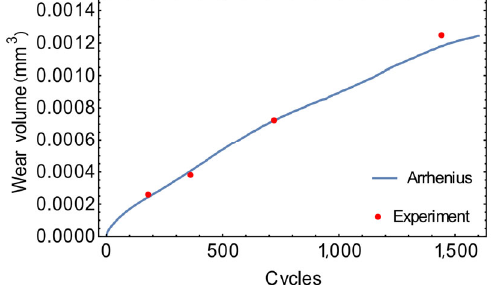
Fig. 5 Wear volume comparison.